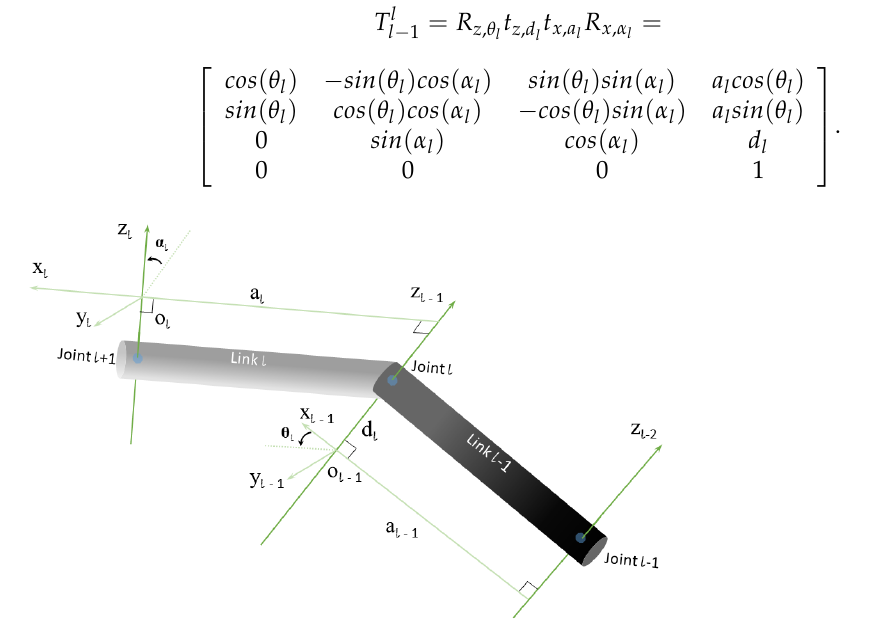
Figure 2. D–H coordinate system of link l of